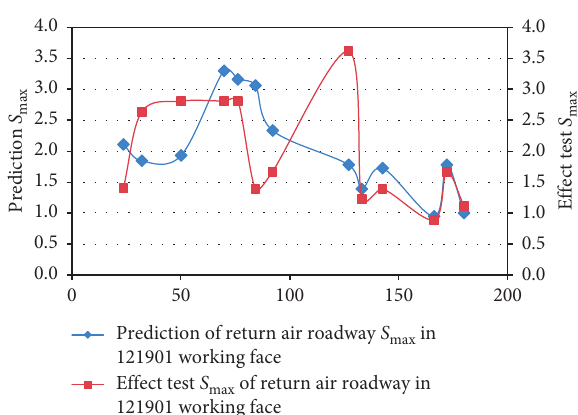
Figure 1: Changes of K 1max index before and after taking pre- ventative measures in the transportation roadway in the 121901 working face.